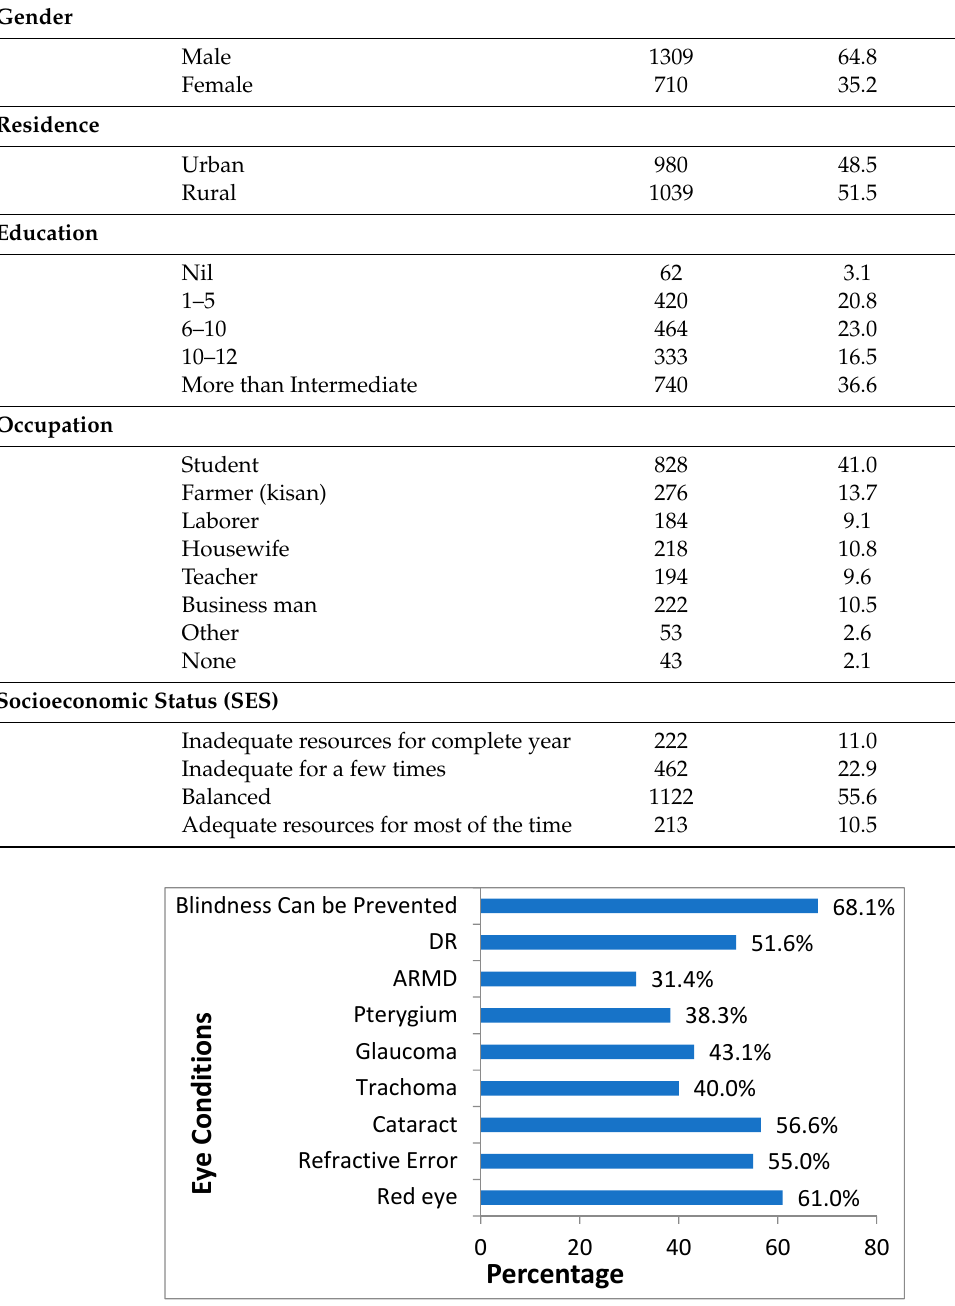
Figure 1. Illustrates the Knowledge level of each eye disease status.